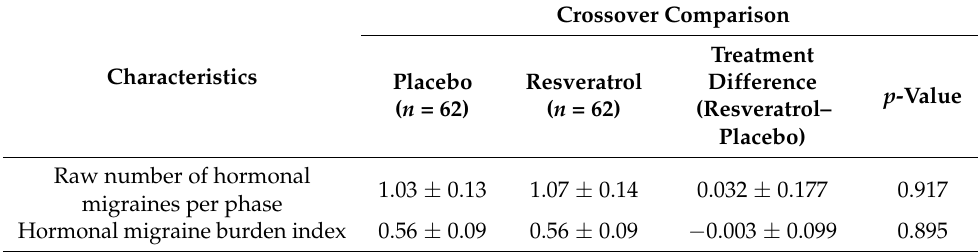
Table 2. Migraine Characteristics.